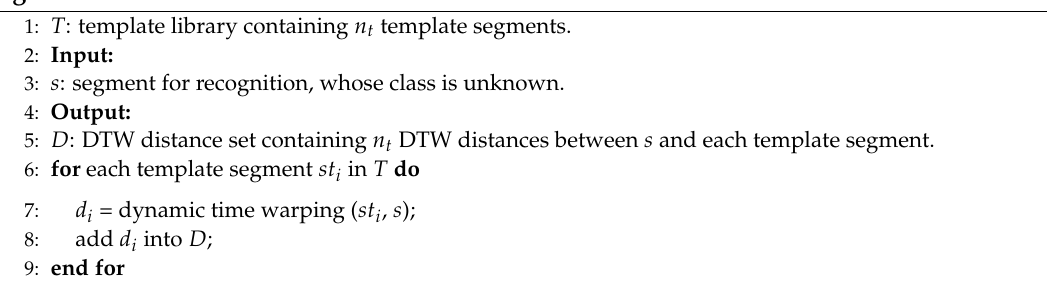
Figure 19. Computational process of the DTW. Algorithm 1: Calculate DTW distance